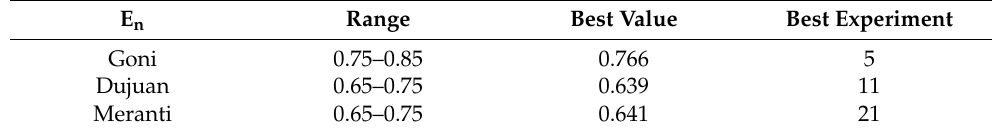
Table 7. E n statistics of the wind speed simulation in the three typhoon